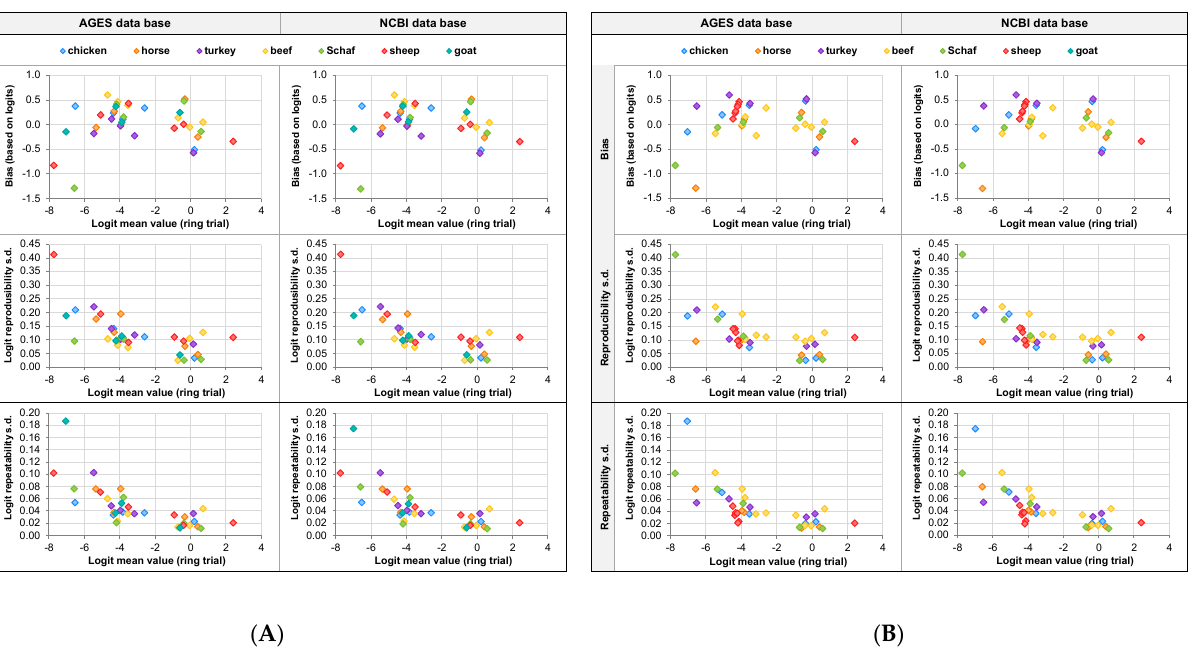
Figure 2. Bias, reproducibility standard deviation, and repeatability standard deviation depending on the overall mean determined in the ring trial based on logit-transformed proportions of animal species. Colors refer to ( A ) the respective animal species and ( B ) the predominant animal species in the respective sample.